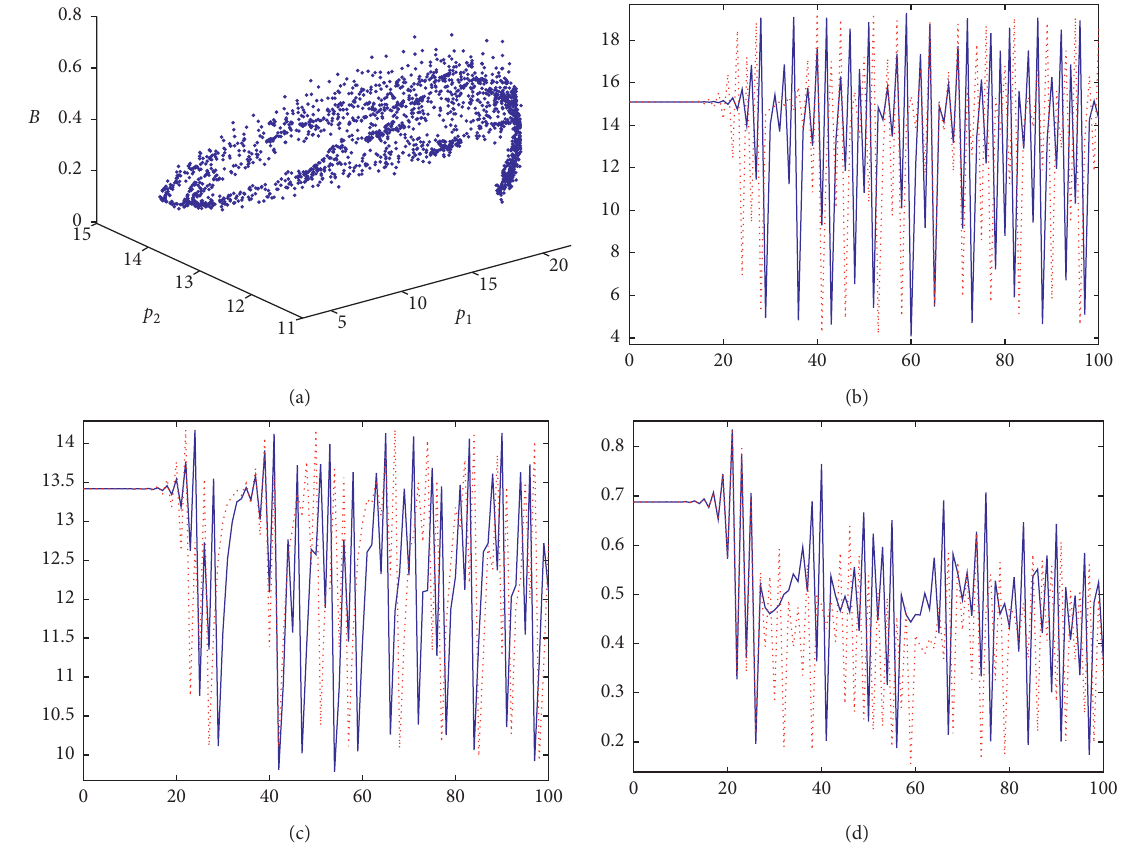
Figure 8: Chaos attractor and the sensitivity to initial